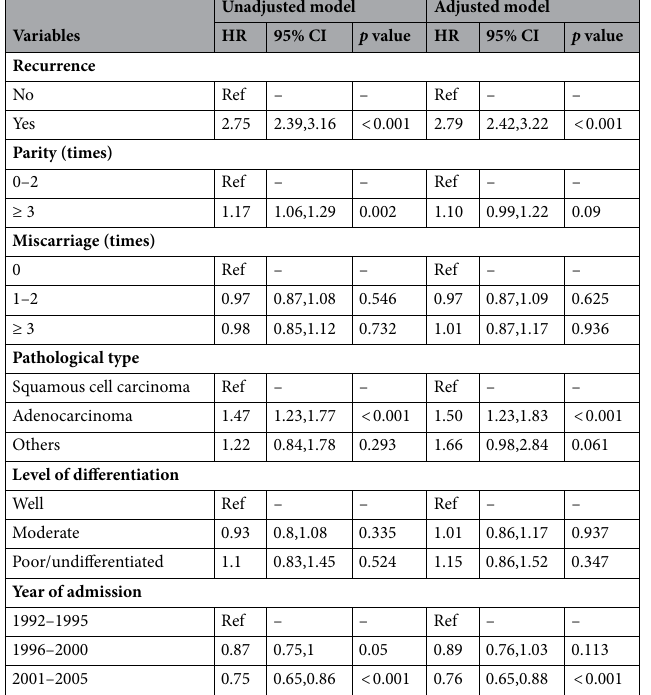
Table 4. Analyzing factors associated with mortality using Cox regression models. HR hazard ratio, CI confidence